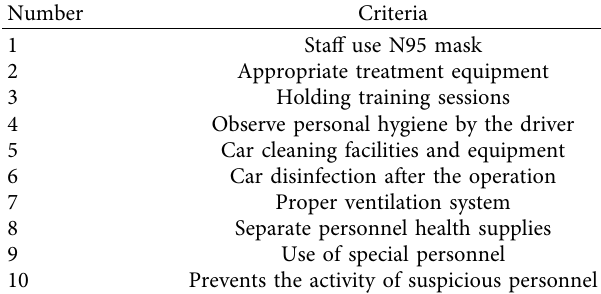
Table 2: Standard criteria of Iran Health